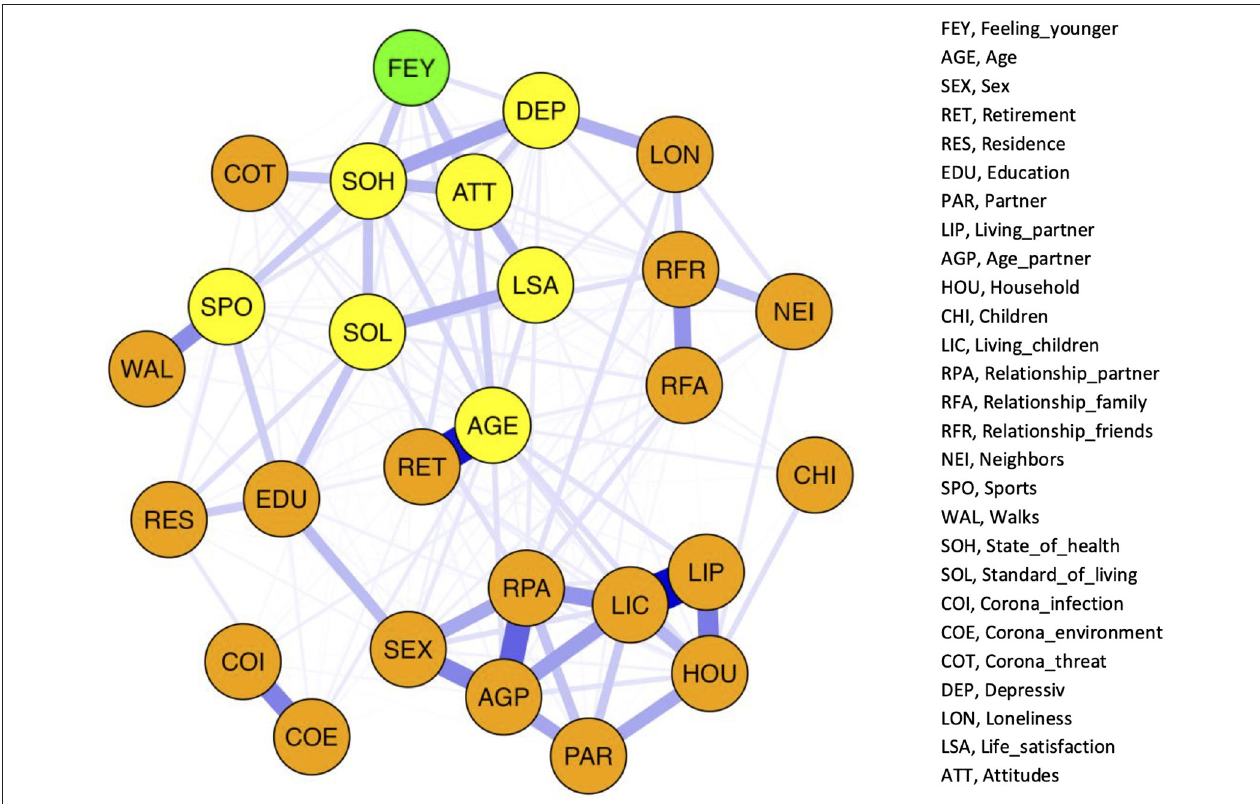
FIGURE 1 | Network structure of the total study population. The nodes display the variables and the edges represent correlations between the nodes. The thickness of the edges corresponds to the strength of the correlation. Green: Feeling_young er (FEY), Yellow: variable directly associated with FEY (AGE, age ; SPO, sports ;